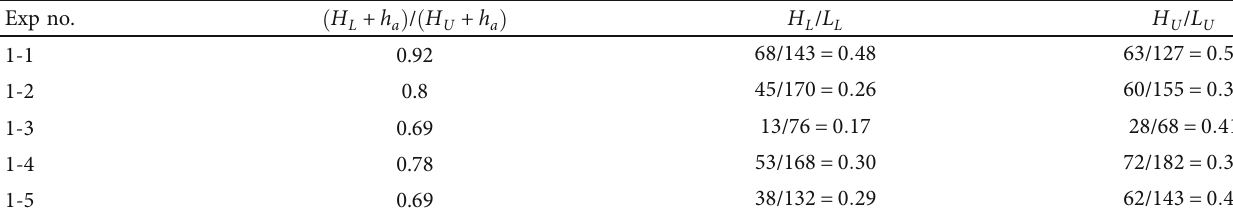
Table 3: Experimental results of physical model with arti fi cial interlayers.